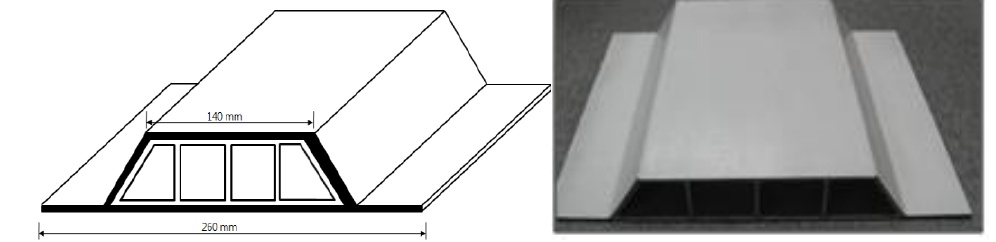
Table 1. Mechanical properties of the hybrid composite beam (HCB).